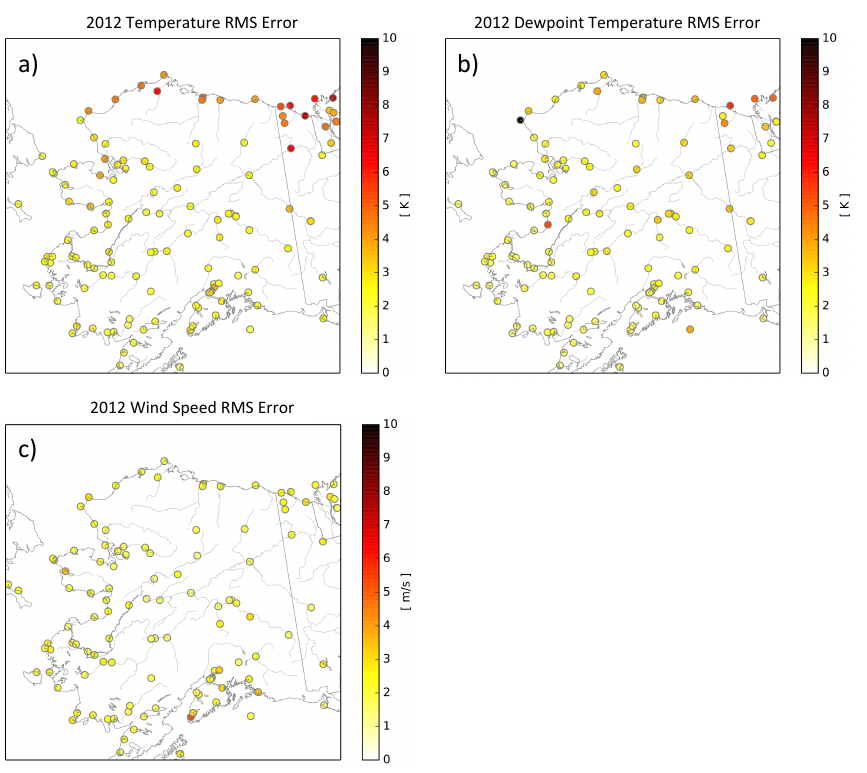
Figure 7. As in Fig. 6, but for